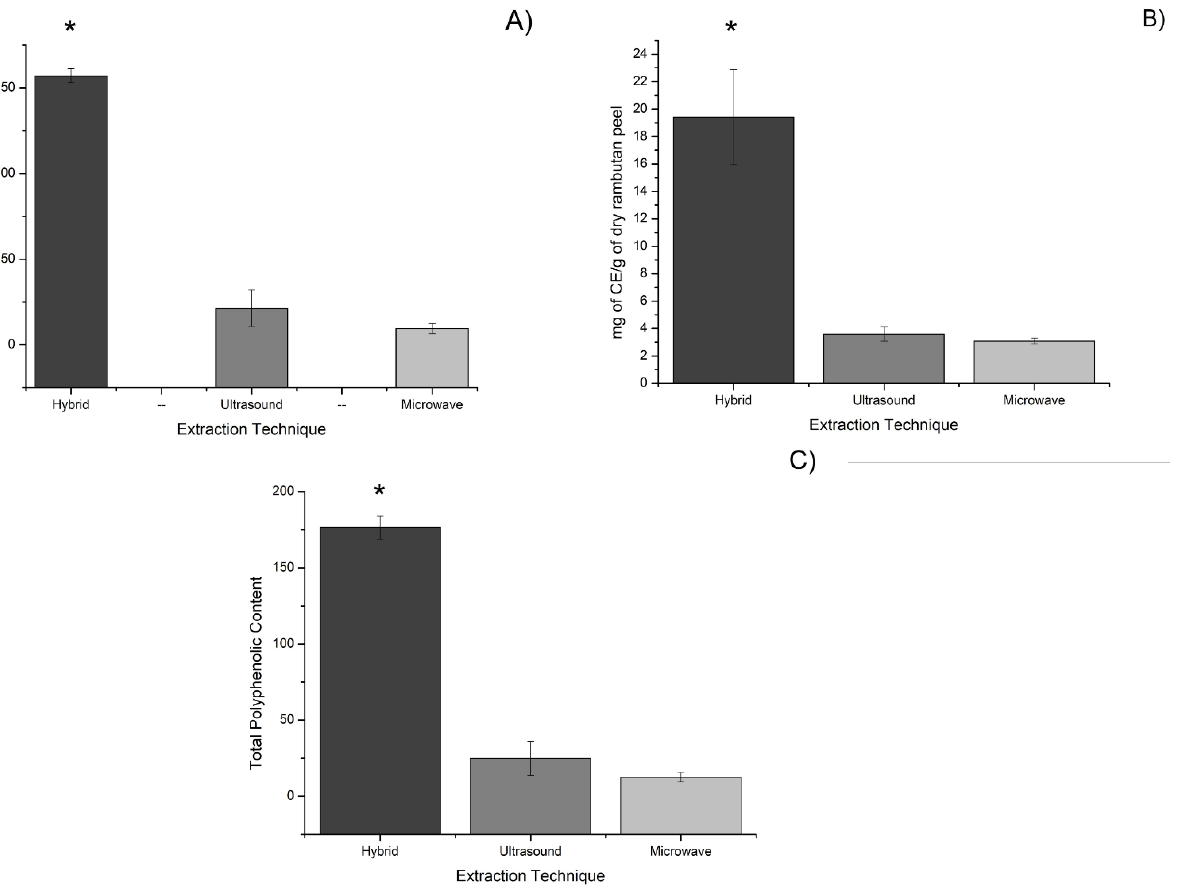
Figure 1. Extraction of polyphenolic compounds from Mexican rambutan peel. Figure ( A ) represents hidrolyzable tannins as mg of gallic acid equivalents/g of dry rambutan peel, Figure ( B ) represents condensed tannins as mg of catechin equivalents/g of dry rambutan peel, and Figure ( C ) represents the total amount of polyphenolic content found in the extraction technique, (*) indicates significant differences ( p < 0.05) between extraction